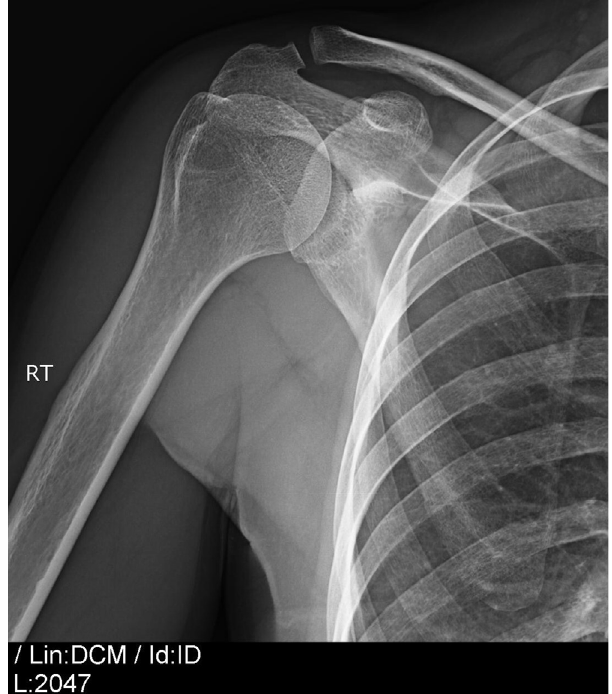
Figure 3. X-ray of the shoulder of the previous patient after the end of the treatment protocol 25 days after the drilling of the